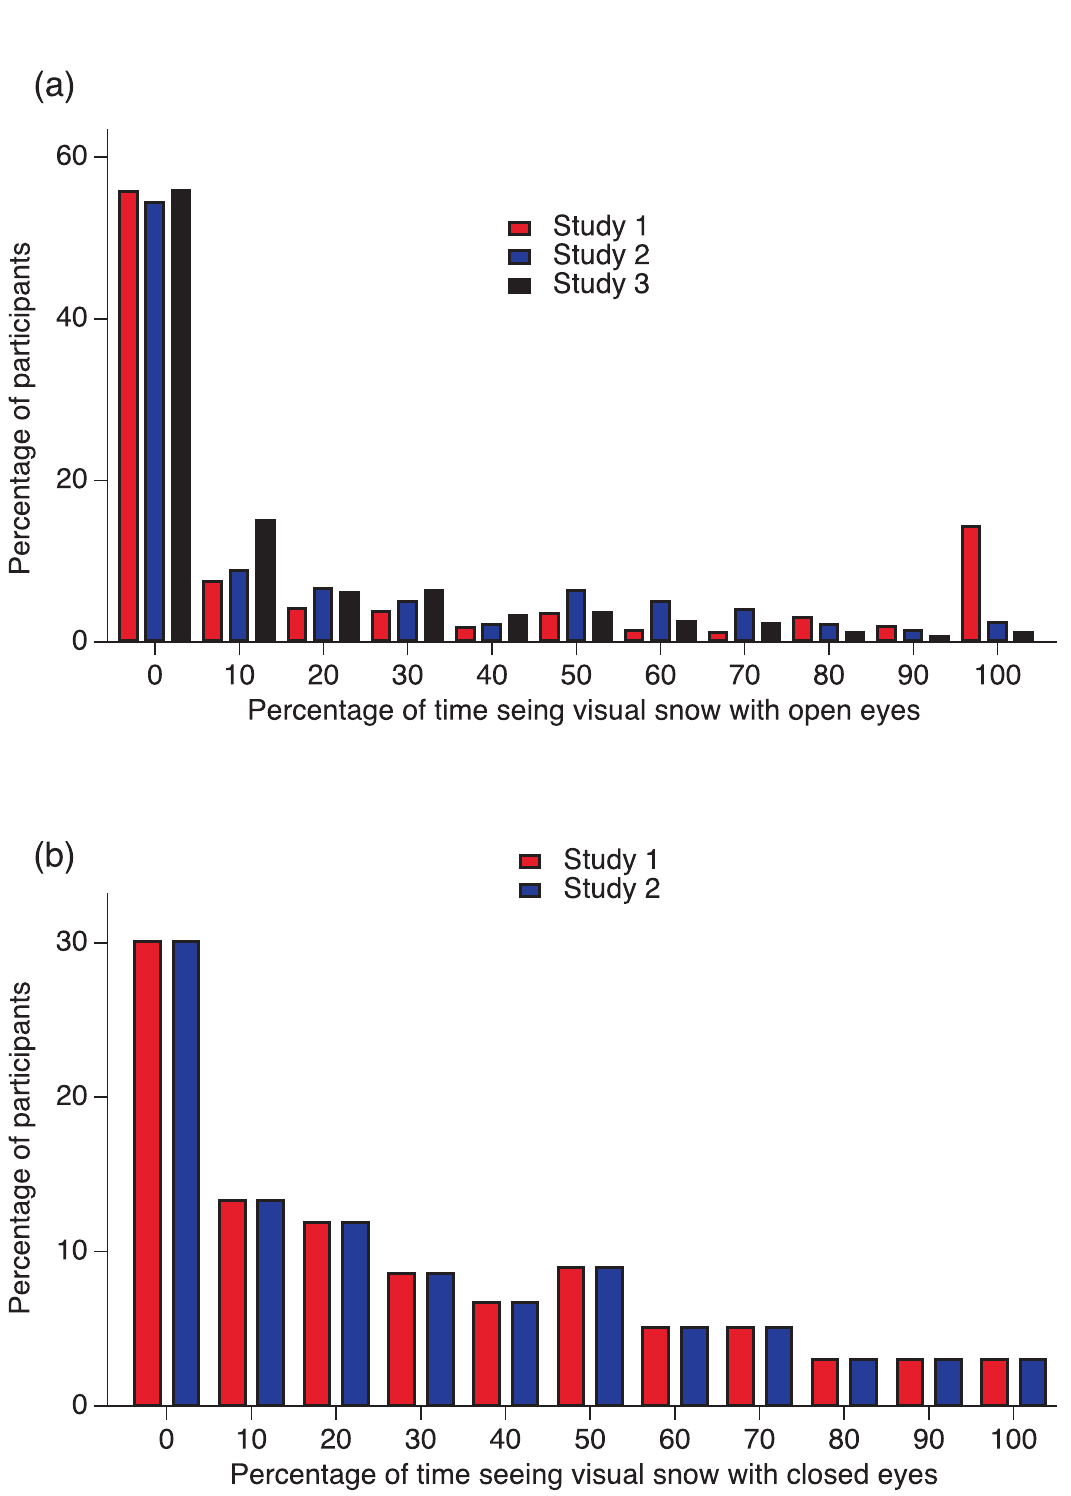
Fig 1. Frequency of visual snow. (a) Percentage of participants seeing visual snow with open eyes for a certain amount of time. (b) Percentage of participants seeing visual snow with open eyes for a certain amount of time. Red bars: Data from Study 1. Blue bars: Data from Study 2. Black bars: Data from Study